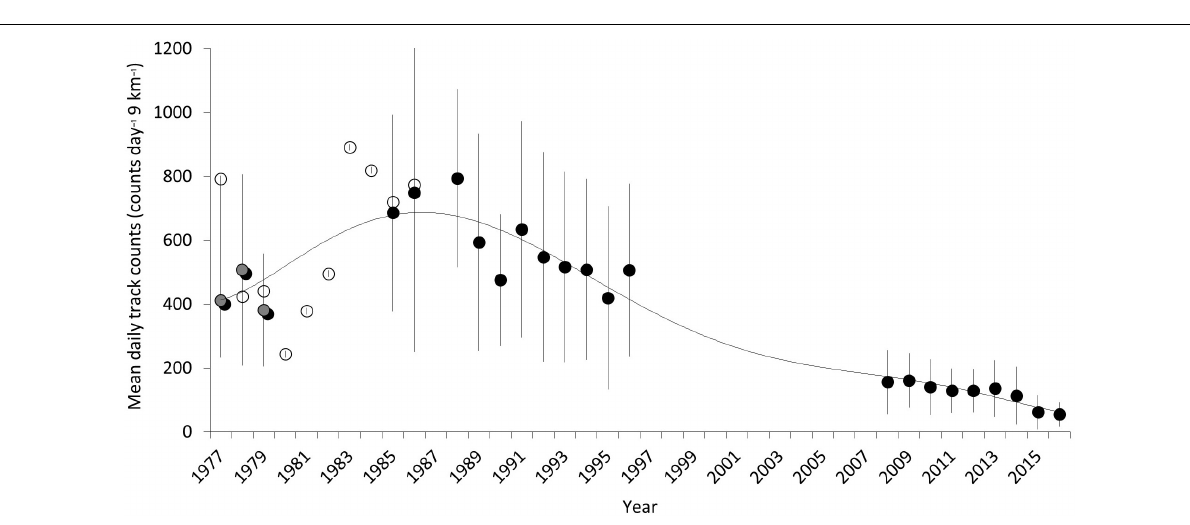
FIGURE 10 | Long-term trend of mean track counts per day for a discrete 120 days season across 9-km of index beach on the northeast of Masirah Island intermittently from 1977 to 2017. Solid points are means from 5-day-per-week counts between K5 and K13. Open points are from weekly counts (Ross and Barwani, 1982) between K5 and K8 and extrapolated to the 9-km distance between K5 and K13. Gray points are weekly counts made between K5 and K13. The trend line is a sixth order polynomial